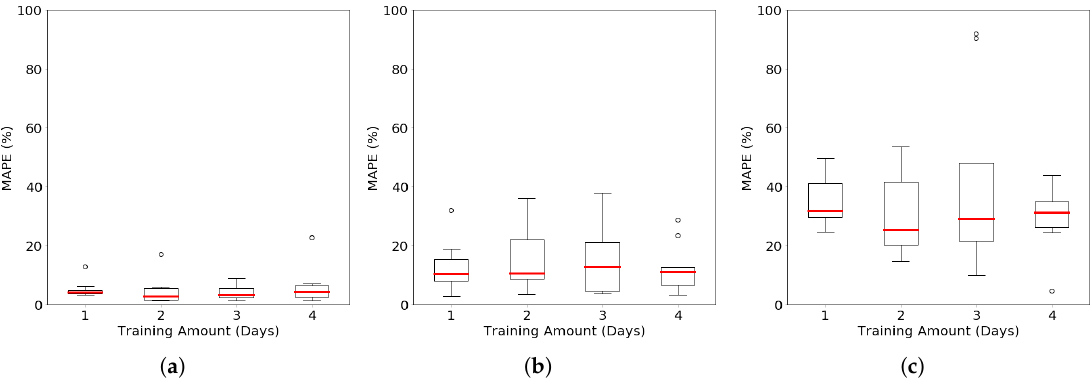
Figure 4. Distribution of the prediction MAPE over different weeks for varying duration of training data using GPR. ( a ) CMU electricity load; ( b ) Y2E2 cooling load; ( c ) Y2E2 lighting load.